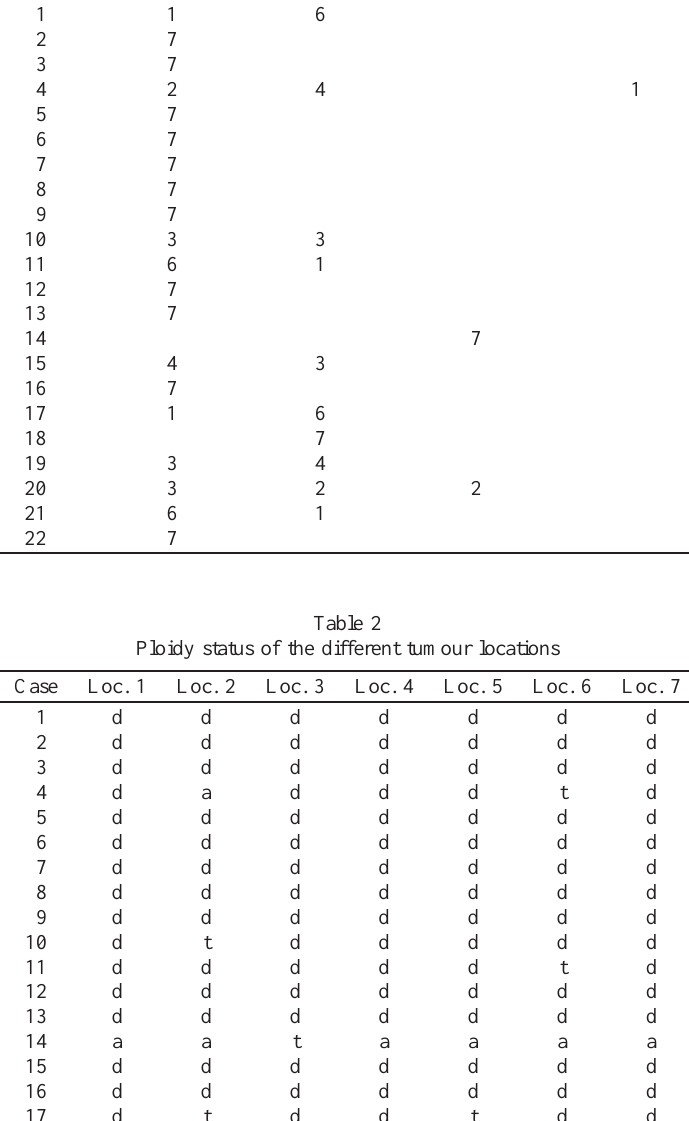
Table 1 Distribution of the different histogram types in the investigated tumours